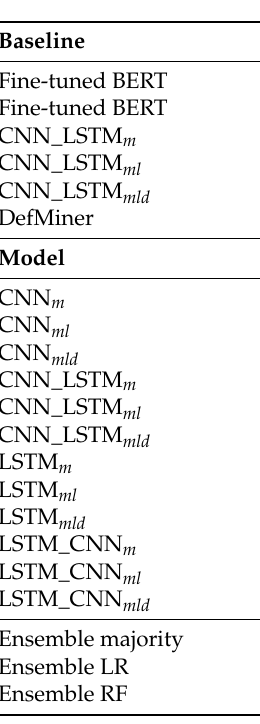
Table 2. Final results for the WFMALL dataset.